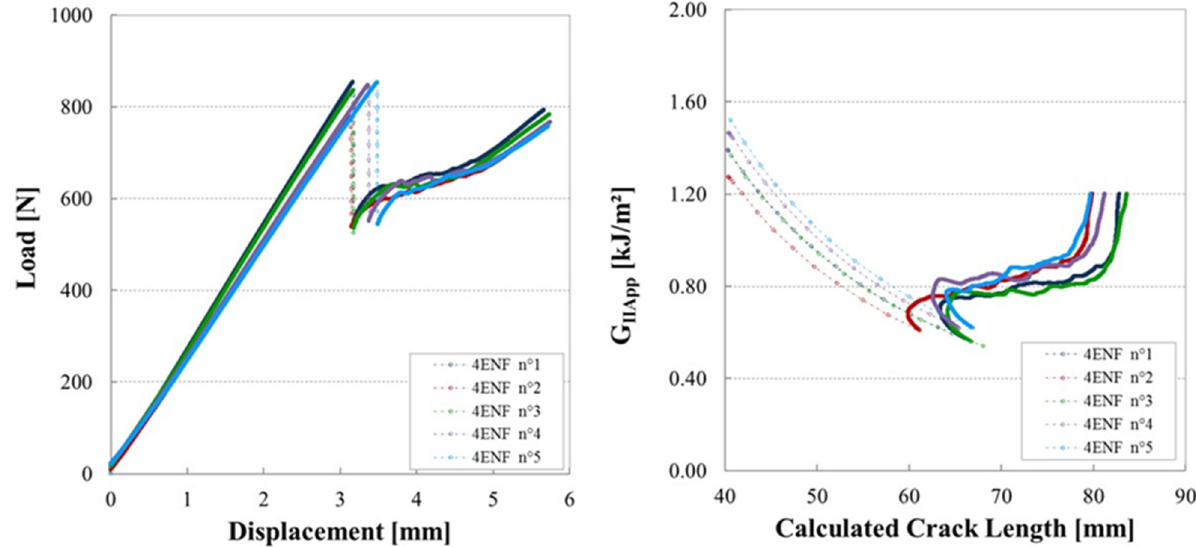
Figure 10. Load vs. displacement curves and R-curves of the Mode II unidirectional laminates.